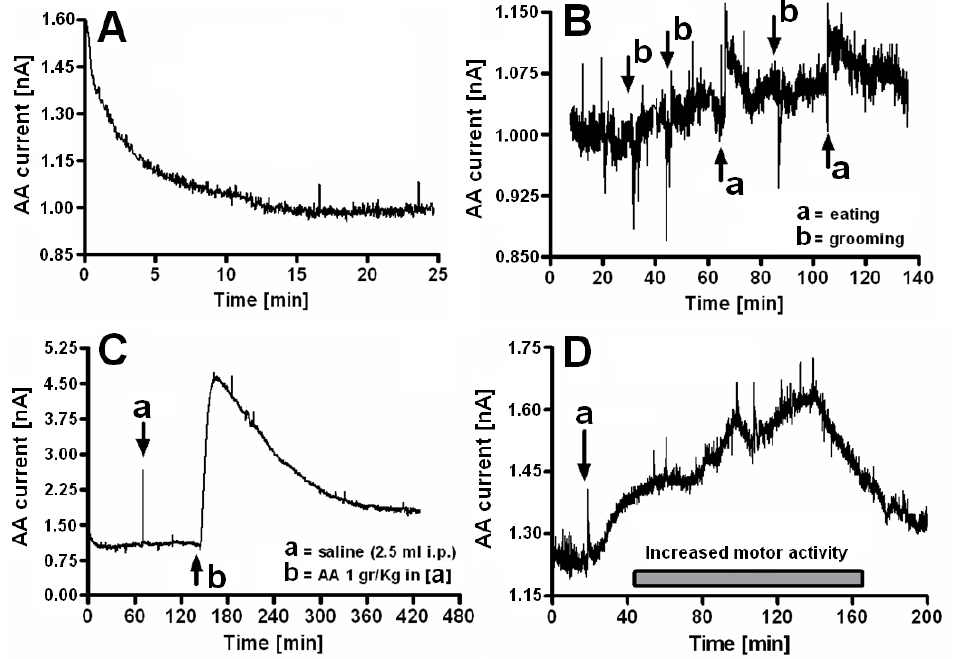
Figure 1. Physiological and pharmacologically-induced changes of striatal ascorbic acid. (A) AA microsensor in-vivo stabilization. (B) Striatal AA physiological changes during eating (a) and grooming (b). (C) Effect of saline (a) and sodium ascorbate (b) (1 gr kg –1 i.p. administration) on striatal AA current. (D) Effect of d-amphetamine (2 mg kg –1 s.c. administration) (a) on striatal AA current and motor